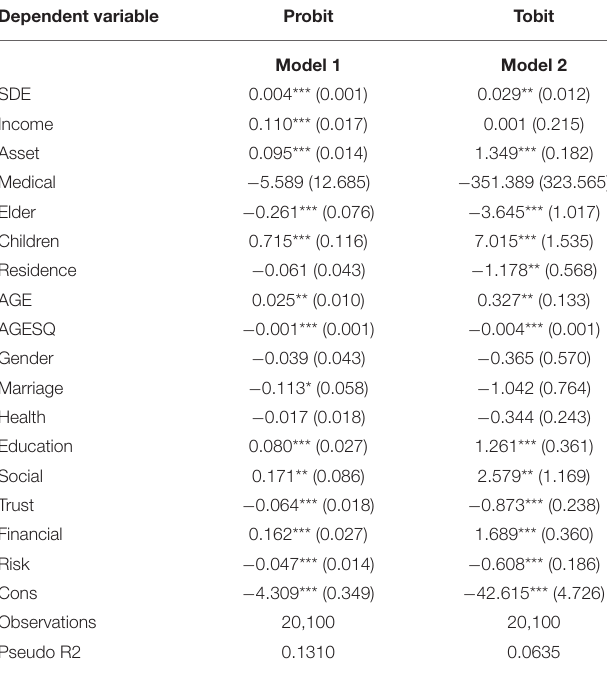
TABLE 3 | Empirical